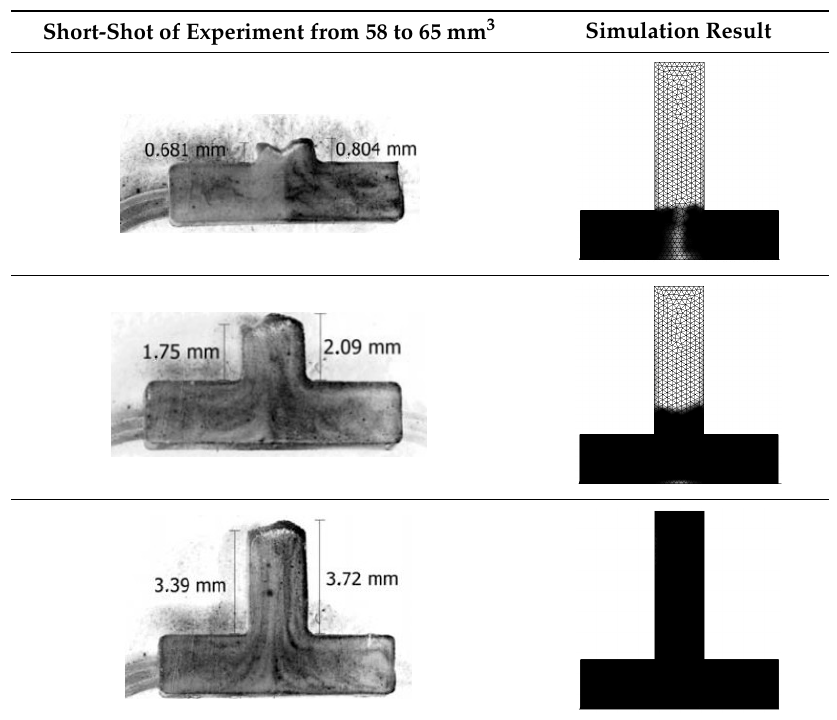
Figure 9. Detail of runners and micro ‐ component [9]: ( a ) floating die cavity insert for micro ‐ injection designed for the Battenfeld injection machine; ( b ) geometry of the ejector; and ( c ) injection channels and moving die mold cavity. Table 1. Comparison between results from experiment and the improved simulation.